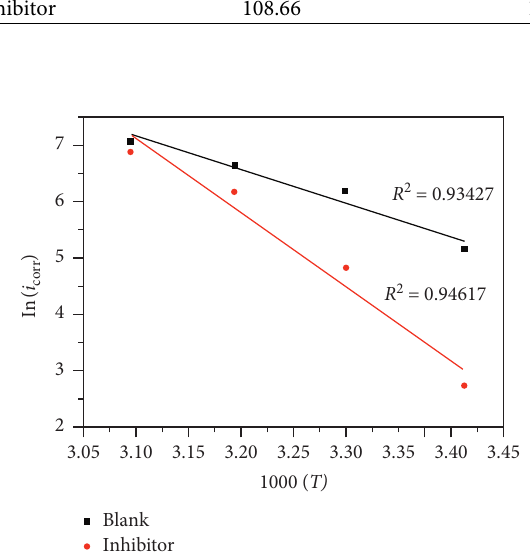
2 SO 4 without and with ACM.